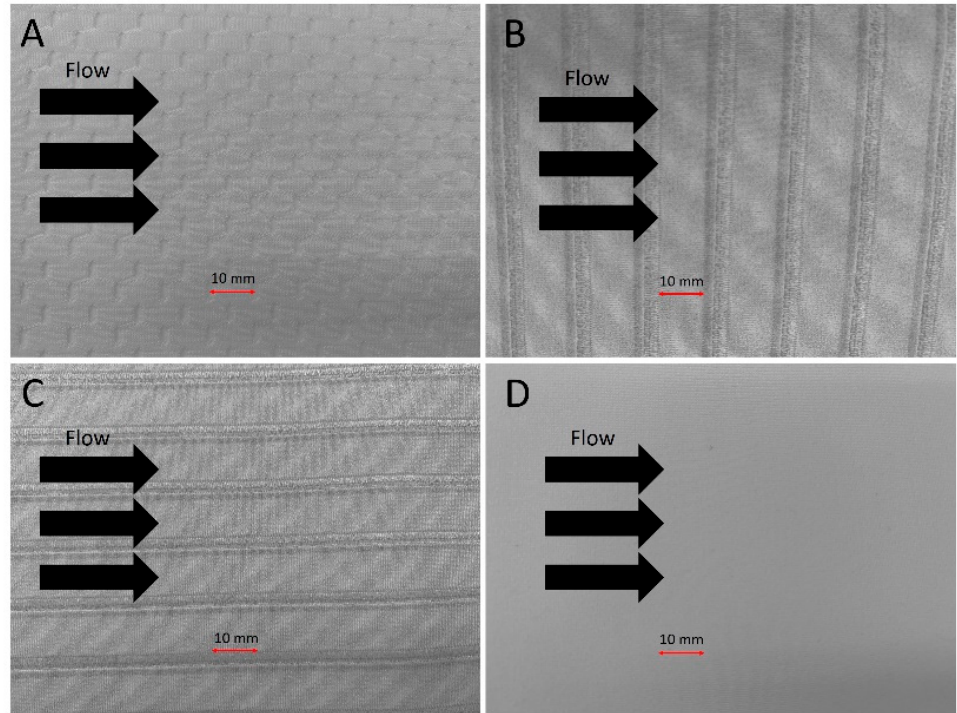
Figure 2. Cycling suit fabric types used in the wind tunnel experiment. (( A ) has small uneven grooves. ( B ) has long and shallow vertical groove lines. ( C ) has horizontal groove lines. ( D ) is a smooth type of fabric.).